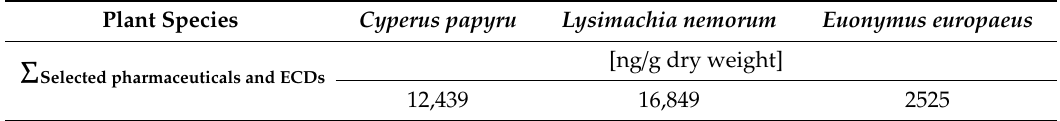
Table 5. The sum of the uptake of selected pharmaceuticals and endocrine disrupting compounds (EDCs) in ng / g dry weight by tested plant species grown in an